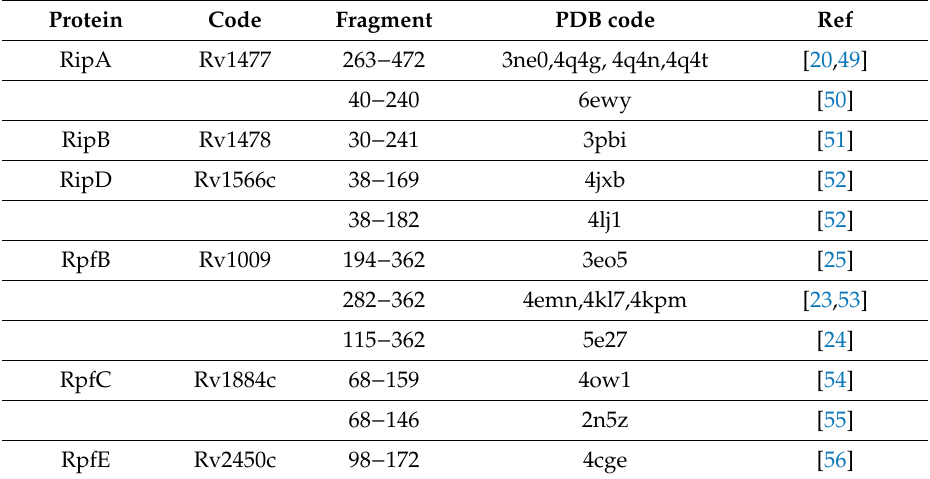
Table 1. Structural data available for septal PGN hydrolases of M.